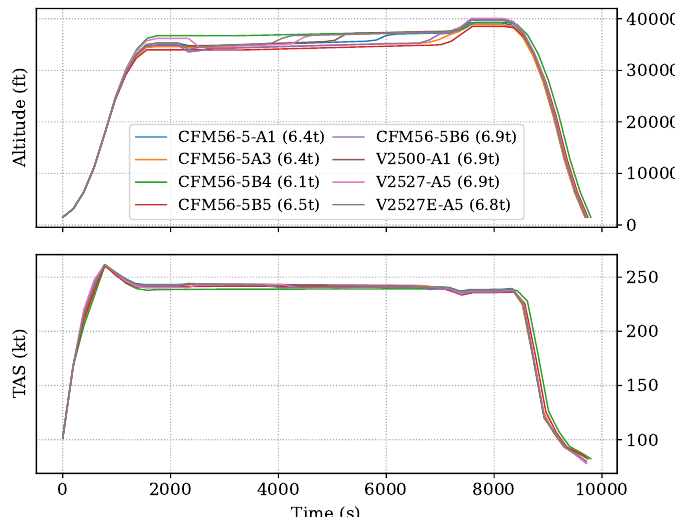
Figure 8. Optimal trajectory with different engine types (A320, optimized for fuel consumption, with 90% of takeoff